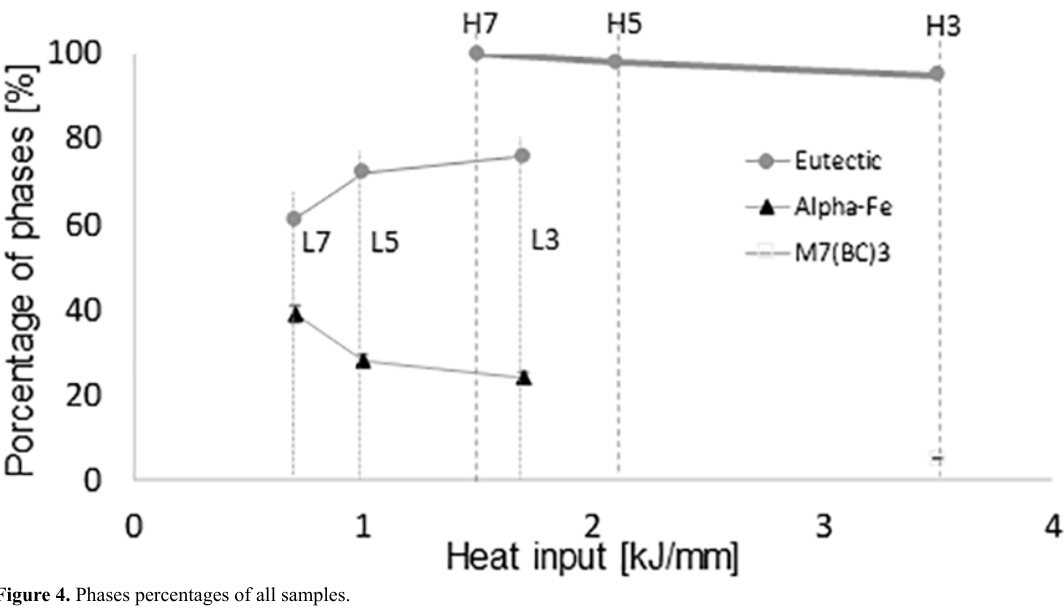
Figure 4. Phases percentages of all samples.